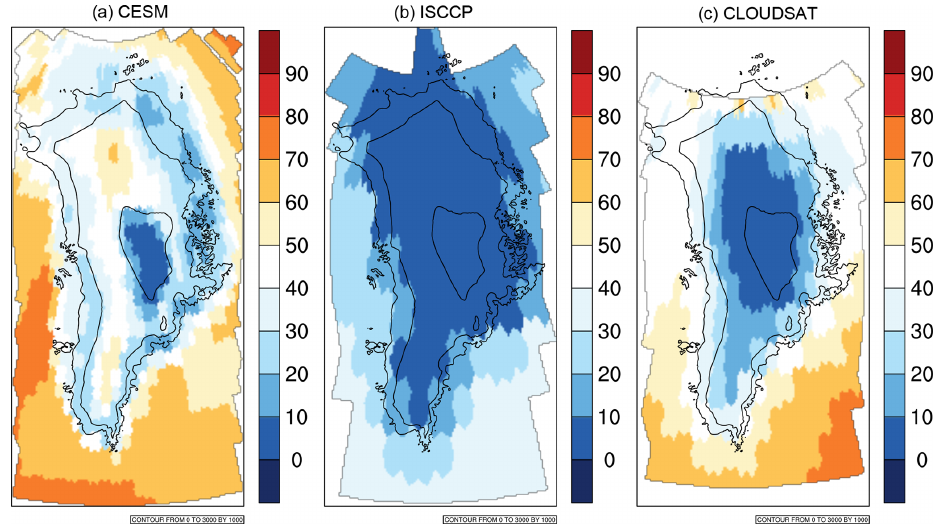
Figure 8. Climatological annual average of low clouds (%) over the GrIS for CESM (a) , ISCCP (Rossow and Schiffer, 1999) (b) , and CLOUDSAT (Kay and Gettelman, 2009) (c) . The downscaled CESM values are used for all elevation contours.